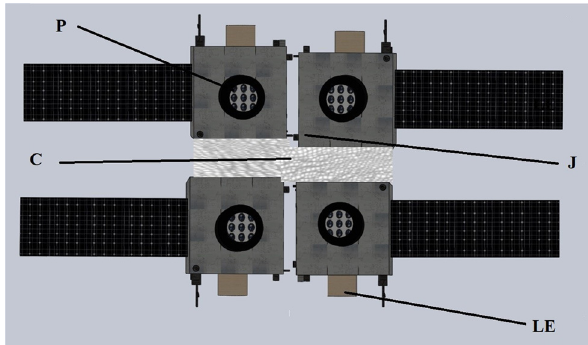
Figure 6: Normal state for the micro/nano joint satellite of high maneuverability. P: remote sensing payload; LE: large - thrust engine; C: depositary cabin of the removal net, and J: joint con - nection mechanism.